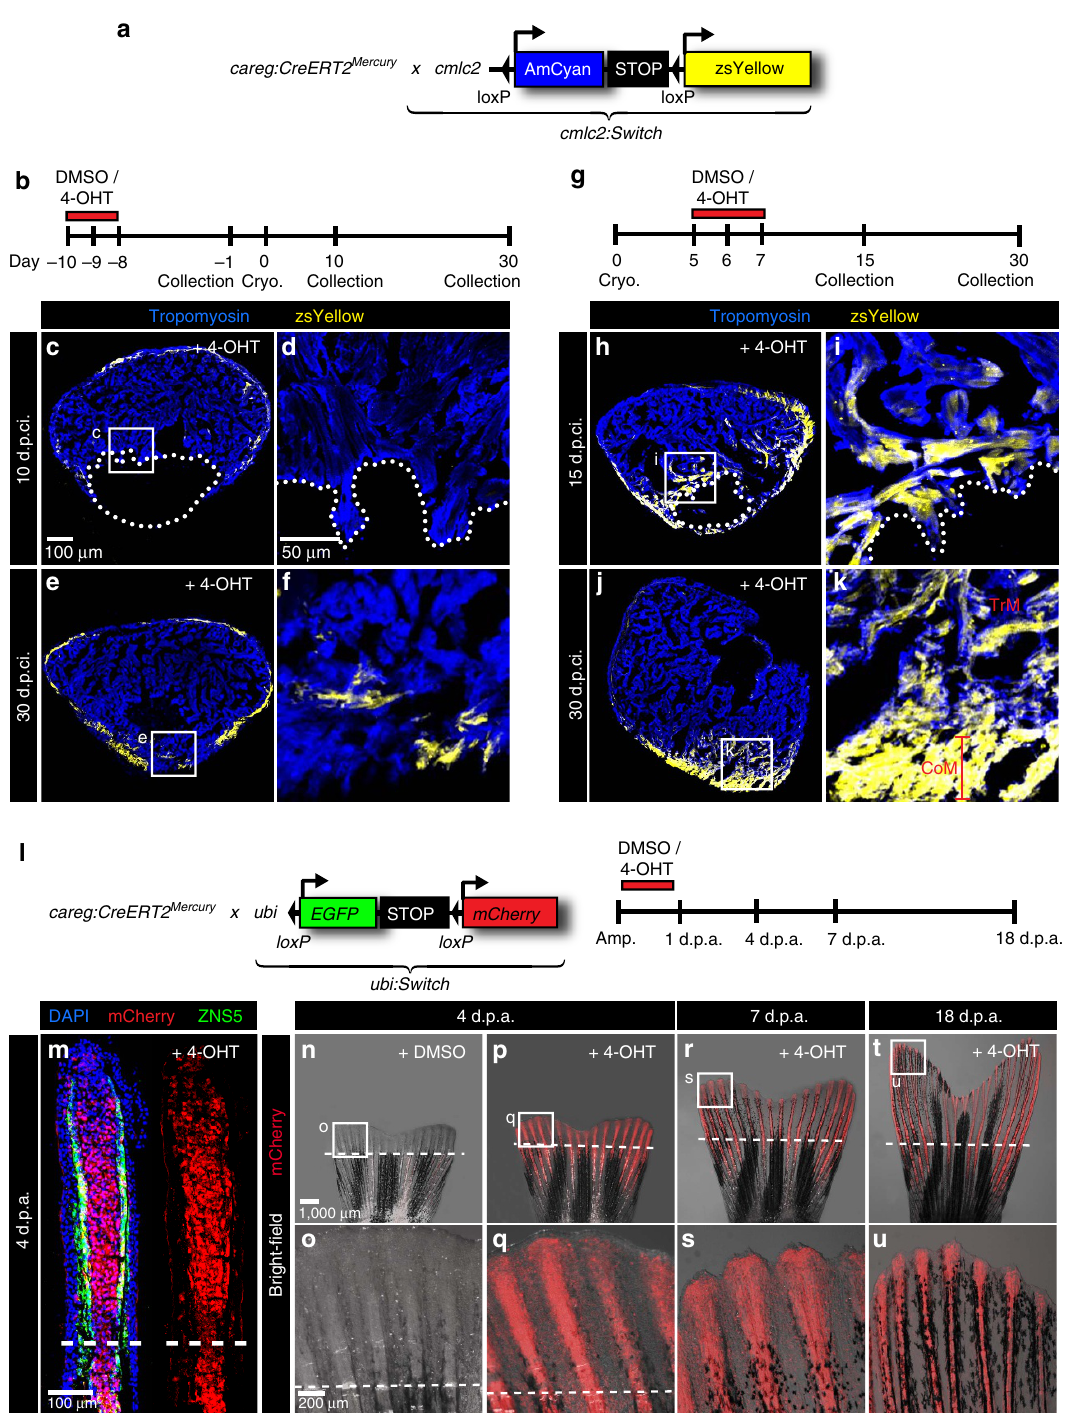
Figure 9 | careg -expressing cells contribute to the regenerating myocardium and fin mesenchyme. ( a , b ) Schematic representation of the transgenic strains and the experimental design for lineage tracing of careg -expressing primordial CMs during ventricle regeneration. ( c – f ) Representative sections of hearts treated with 4-OHT before cryoinjury to label the primordial layer, stained with antibody against Tropomyosin (blue). ( c , d ) At 10 d.p.ci., no zsYellow is detected in the trabecular myocardium at the injury site, indicating that primordial CMs do not contribute to the regeneration zone along the post- cryolesioned tissue. ( e , f ) At 30 d.p.ci., the zsYellow-positive primordial layer regenerates incompletely. ( g ) Experimental design for lineage tracing of careg - expressing dedifferentiated CMs during ventricle regeneration. ( h – k ) Representative sections of hearts treated with 4-OHT after cryoinjury hearts immunostained against Tropomyosin (blue) ( h , i ) At 15 d.p.ci., zsYellow is expressed in the trabecular myocardium at the injury site. ( j , k ). At 30 d.p.ci., zsYellow-positive CMs are detected in the trabecular (TrM) and cortical myocardium (CoM) of the regenerated muscle. N Z 8. ( l ) Transgenic strains and the design of lineage tracing experiments during fin regeneration. ( m ) Longitudinal section of lineage-labelled fins at 3 d.p.a., stained for osteoblasts using the Zns5 antibody (green) and for nuclei with DAPI (blue). mCherry is detected in the entire mesenchyme of the regenerative outgrowth and below the amputation plane. N ¼ 6. ( n – u ) Live-imaging of the same lineage-labelled fin at different time points of regeneration. The regenerative outgrowth and the stump tissue are labelled with mCherry. N ¼